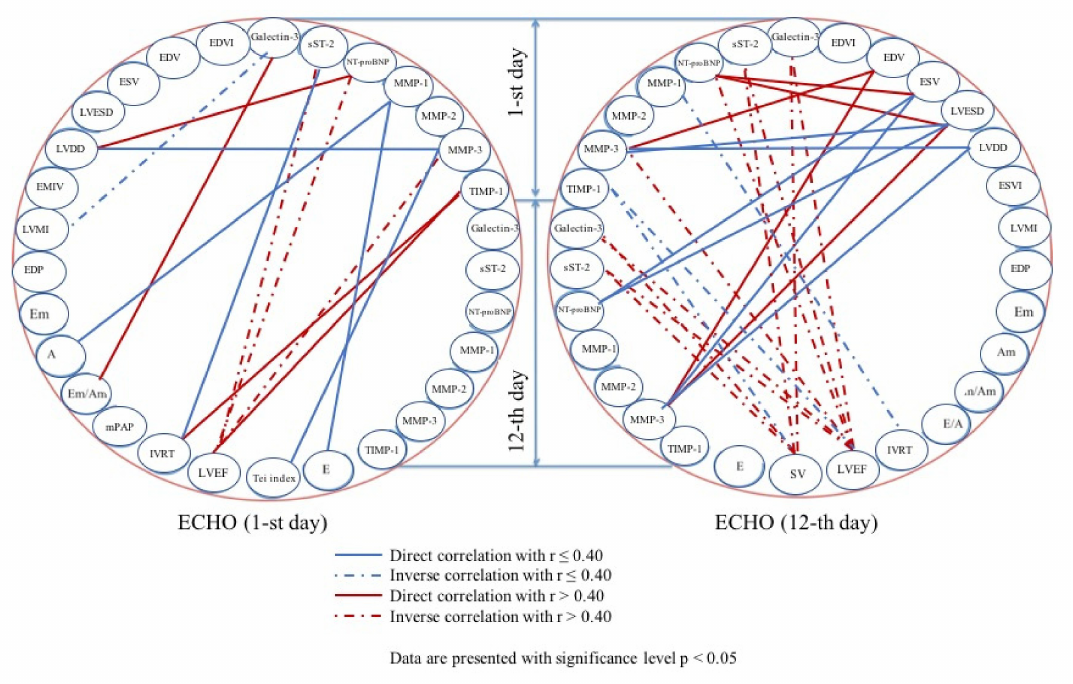
Figure 3. Correlation analysis of echocardiographic parameters and serum biomarkers in patients with ST-segment elevation myocardial infarction and reduced left ventricular ejection fraction (HFrEF, only statistically significant correlations with Spearman’s rho > 0.4–0.7 are marked red). Abbreviations used: A—late diastolic ventricular filling velocity, Am—late diastolic myocardial velocity, E—early diastolic ventricular filling, E / A—early to late diastolic ventricular filling velocity ratio, Em—early diastolic myocardial velocity, Em / Am—early to late diastolic myocardial velocity ratio, EDP—left ventricular end-diastolic pressure, EDV—left ventricular end-diastolic volume, EDVI—end-diastolic volume index (left ventricular end-diastolic volume / body surface area), EMIV—early mitral inflow velocity, ESV—left ventricular end-systolic volume (ESV), ESVI—end-systolic volume index (left ventricular end-systolic volume / body surface area), IVRT—isovolumic relaxation time, LVDD—left ventricular end-diastolic diameter, LVEF—left ventricular ejection fraction, LVESD—left ventricular end-systolic diameter, LVMI—left ventricular mass index (left ventricular mass / body surface area), mPAP—pulmonary artery pressure, MMP—matrix metalloproteinase, NT-proBNP—N-terminal pro-B-type natriuretic peptide, sST2—soluble suppression of tumorigenicity 2, SV—stroke volume, TIMP—tissue inhibitor of